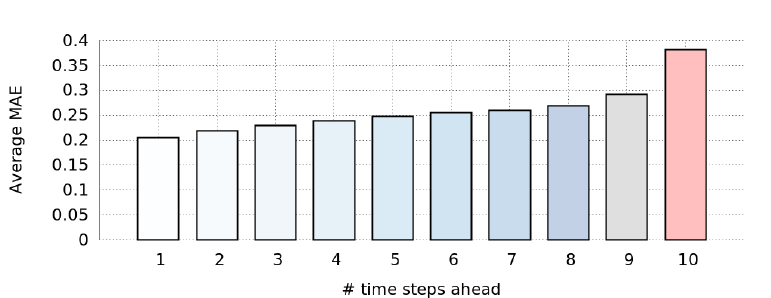
Figure 15. RBR average Mean Absolute Error (MAE) of the EtEQ predictions.